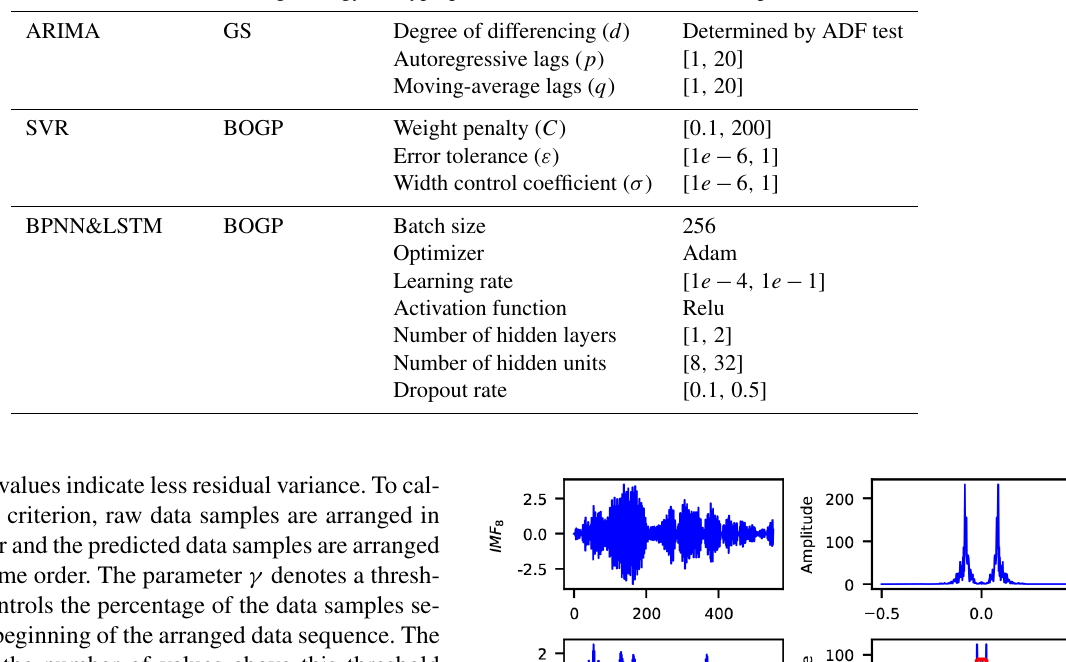
Table 1. The hyperparameters, tuning strategies, and search ranges for the compared data-driven models. Data-driven model